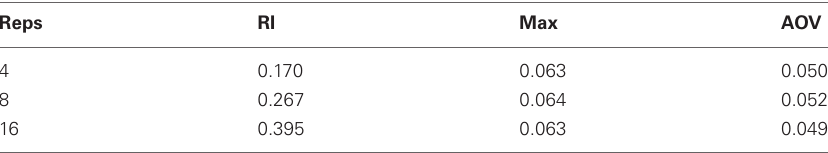
Table 1 | Type I error rate for the test of AB in the 2 × 2 design.